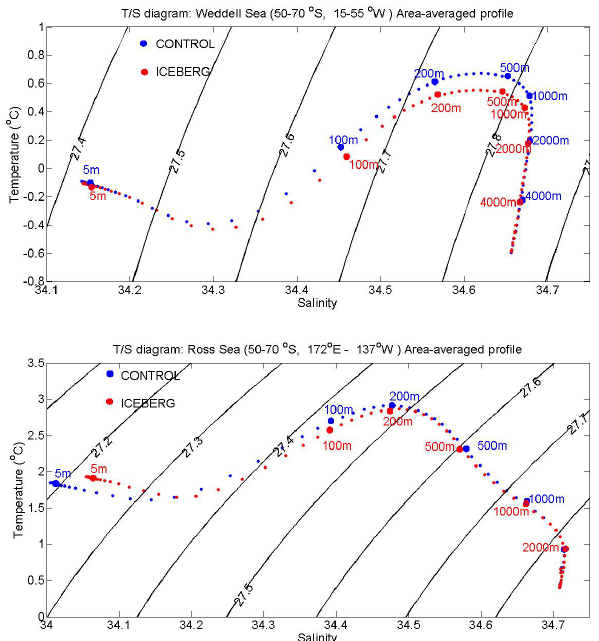
Figure 10. Area-averaged T / S diagrams representative of the Wed- dell Sea (50–70 ◦ S, 15–55 ◦ W; upper panel) and the Ross Sea (50– 70 ◦ S, 172 ◦ E–137 ◦ W; lower panel), for ICEBERG (red points) and CONTROL (blue points).